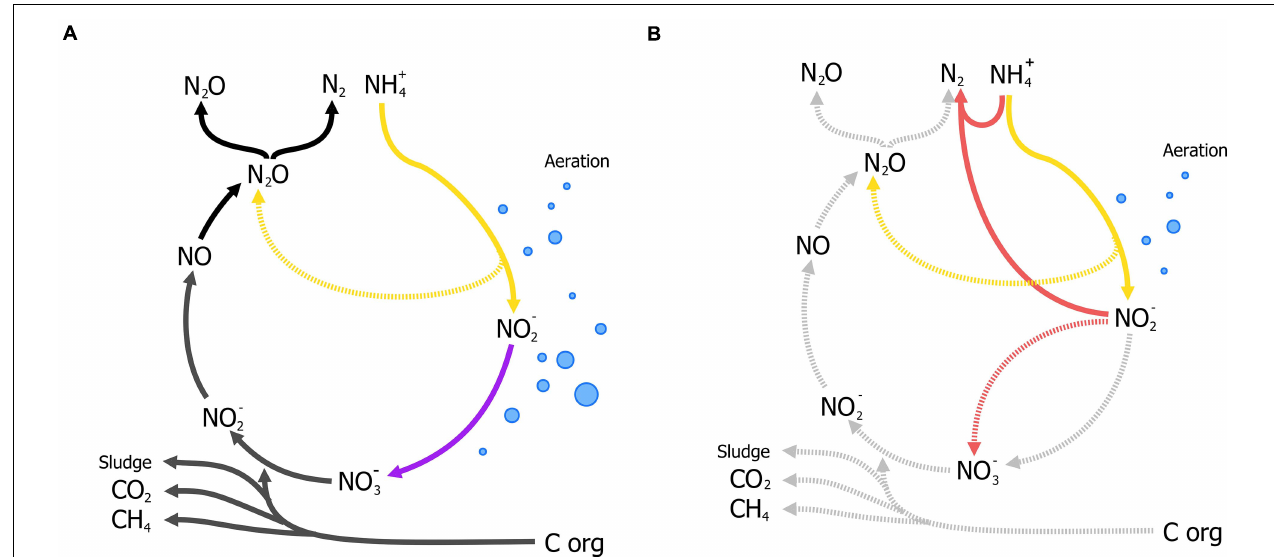
FIGURE 4 | Traditional Nitrification/denitrification process (N/dN) (A) and anammox-mediated removal of ammonia coupled to partial nitritation (B) . (A) Shows the input and byproducts of the N/dN process: aeration (blue bubbles) for the complete oxidation of ammonia by aerobic ammonia oxidizers (AOB, in yellow) and nitrite oxidizing bacteria (NOB, in purple including complete ammonia oxidizers), organic carbon as electron donor for denitrification, and the production of sludge, and potential release of GHG gases (N 2 O) represented in dark gray. Potential emissions of N 2 O during nitrification (yellow, broken line) could take place under oxygen limitation (Caranto et al., 2016; Thakur and Medhi, 2019). (B) The partial-nitritation/anammox process (PN/A), where nitrite from partial-nitrification by AOB (in yellow) requiring less aeration (blue bubbles), is used to oxidize ammonia directly by anammox bacteria (in red), without performing the complete nitrification-denitrification (broken lines, light gray). Aeration control is crucial to balance nitrite production and the prevention of N 2 O from oxygen-limited